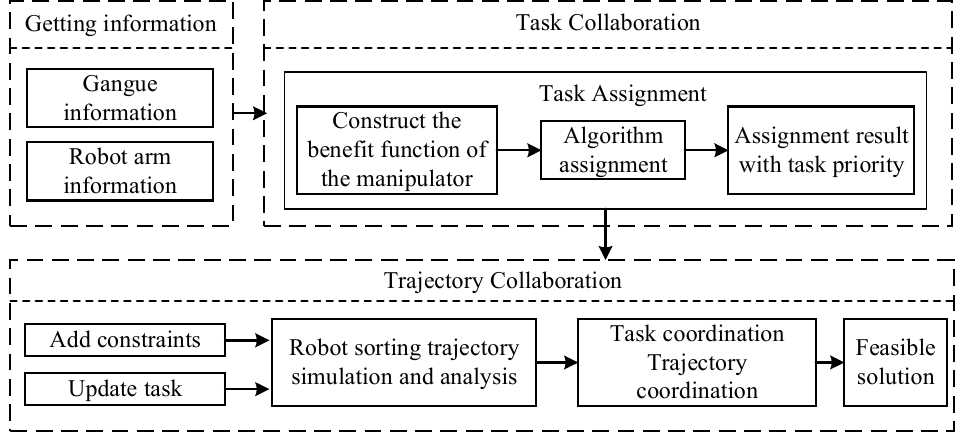
Figure 2. Cooperative sorting principles of multi-arm coal and gangue sorting robot.